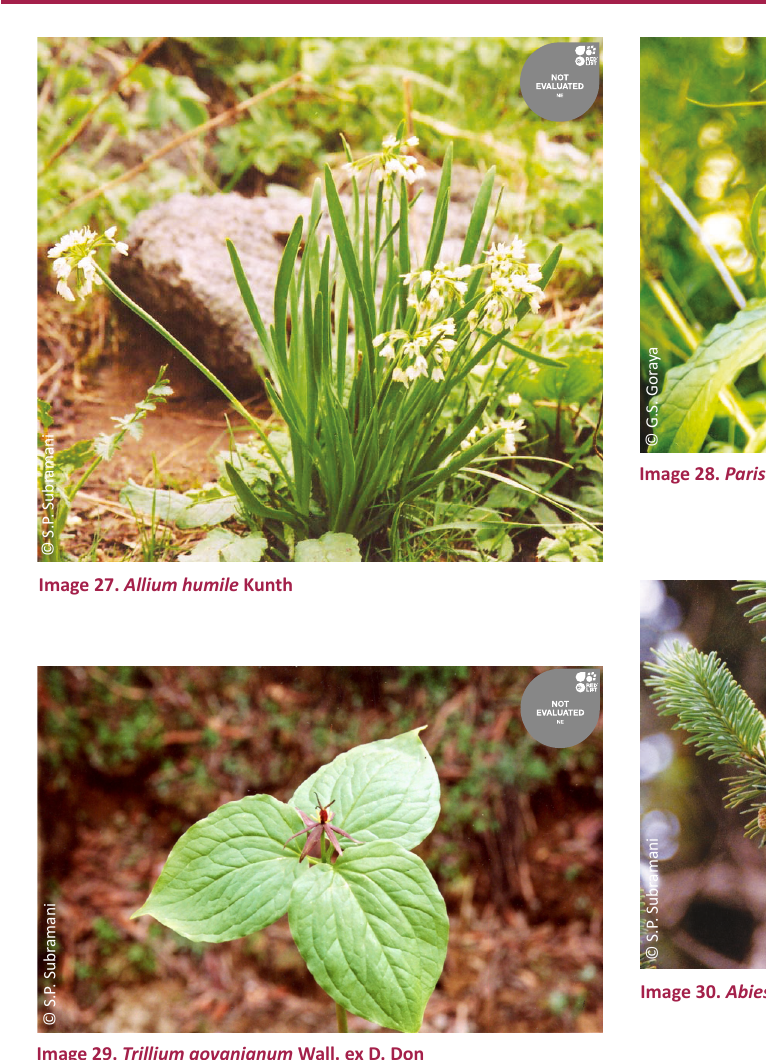
Image 29. Trillium govanianum Wall. ex D. Don